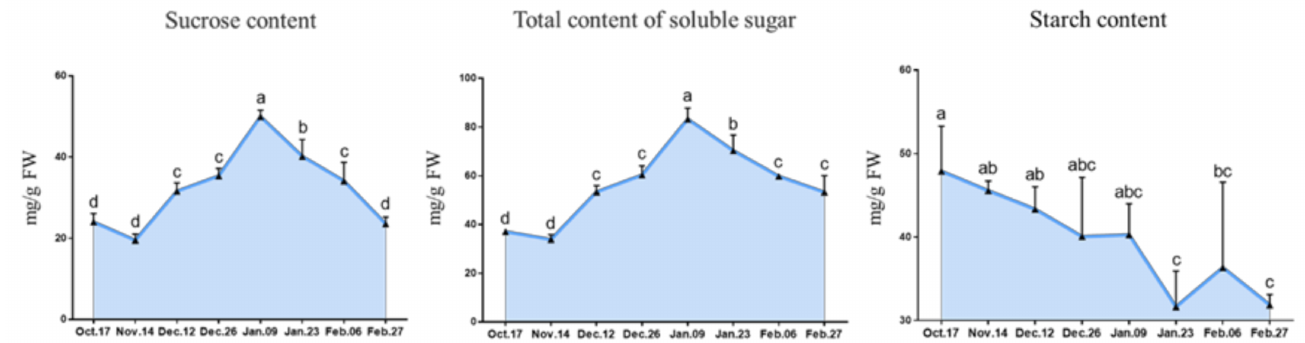
Figure 5. The changes in sugar and carbohydrate contents during the bud dormancy period of ‘Meiju’. Each bar represents the mean ± SEM ( n = 3). The experimental time was from 2018 to 2019, and the data were processed by IBM SPSS Statistics 26. Different letters indicate a significant difference among different dates ( p <